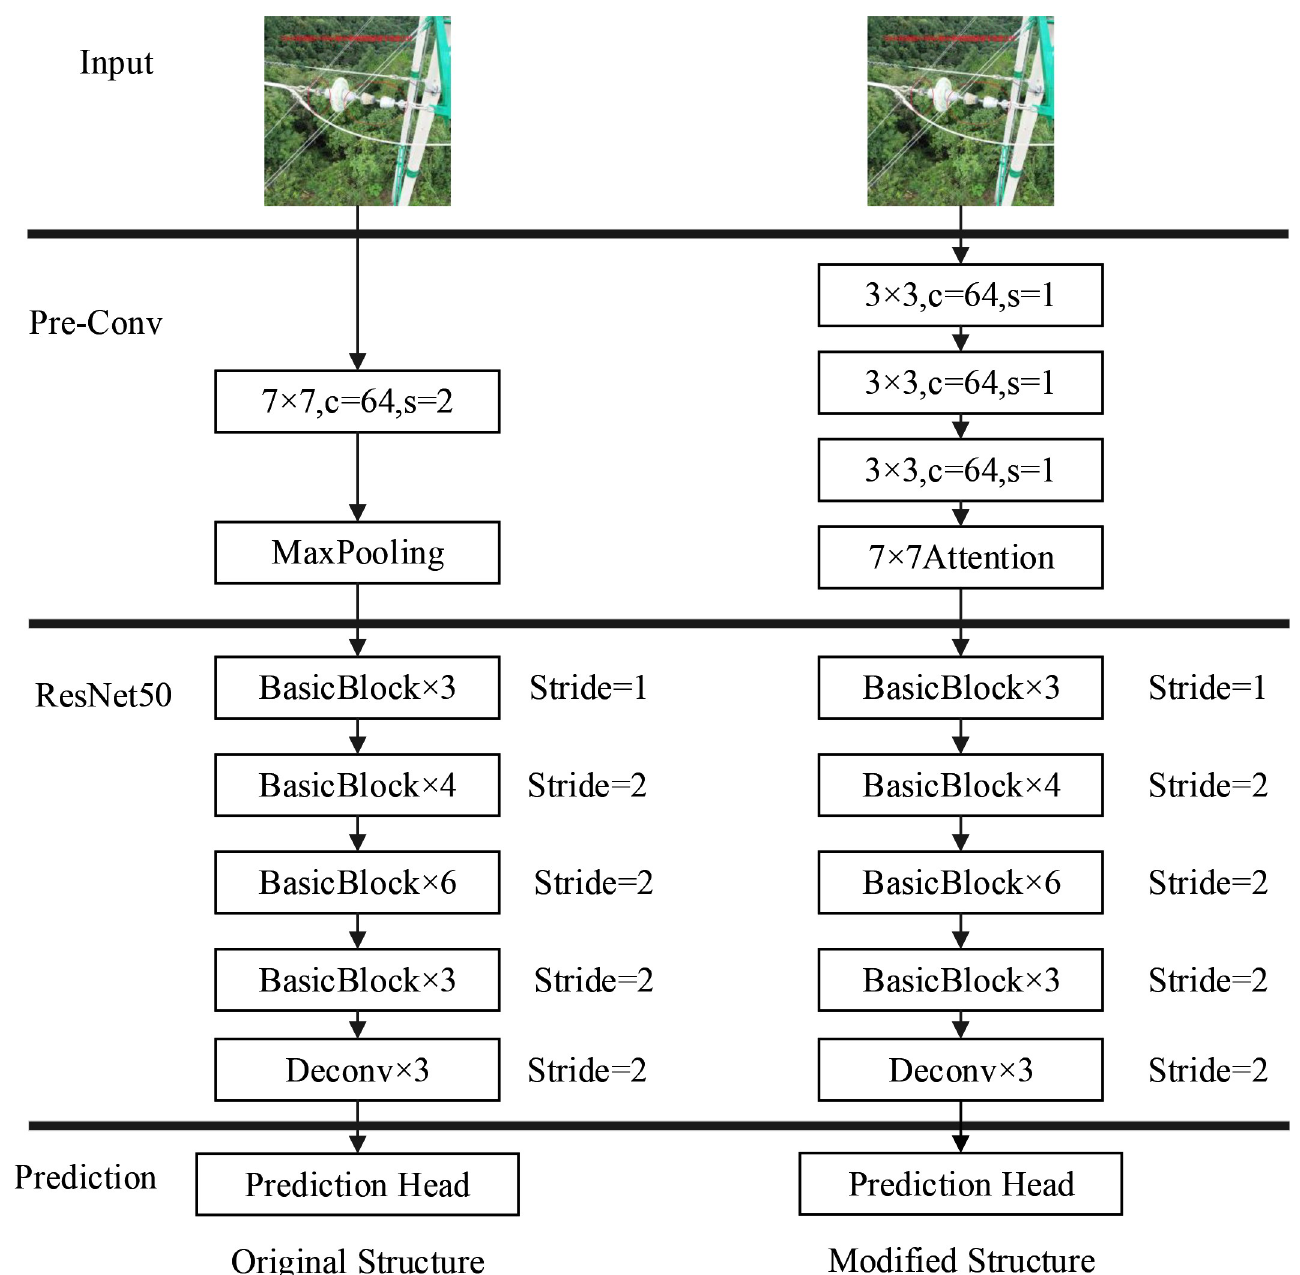
Fig 3. Comparison between the original model structure and the improved one.